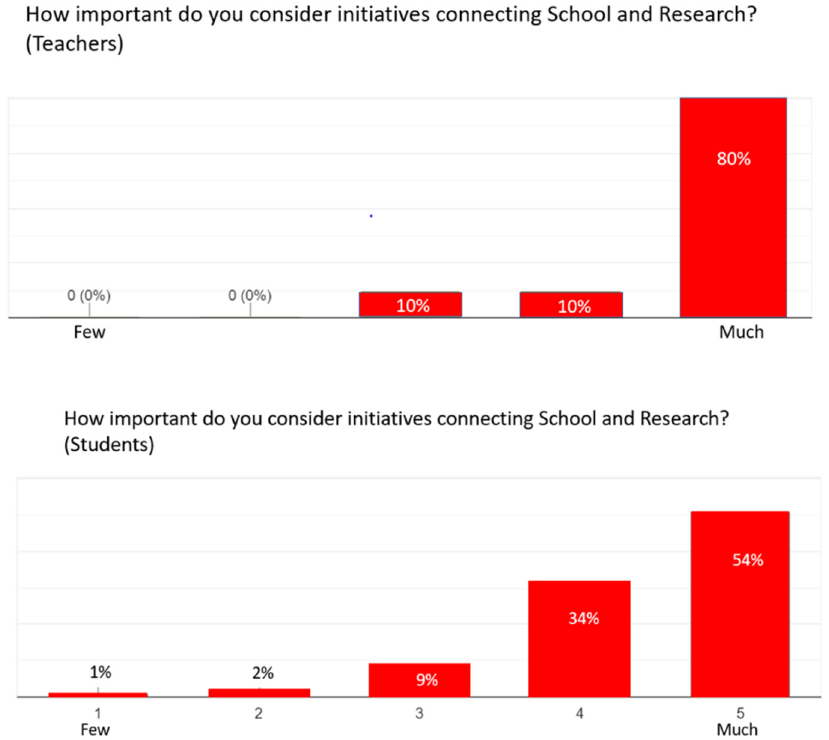
Figure 7. Cumulative values showing percentage of the feedback received for the first question from teachers and students, concerning all the played Salvina’s adventures.